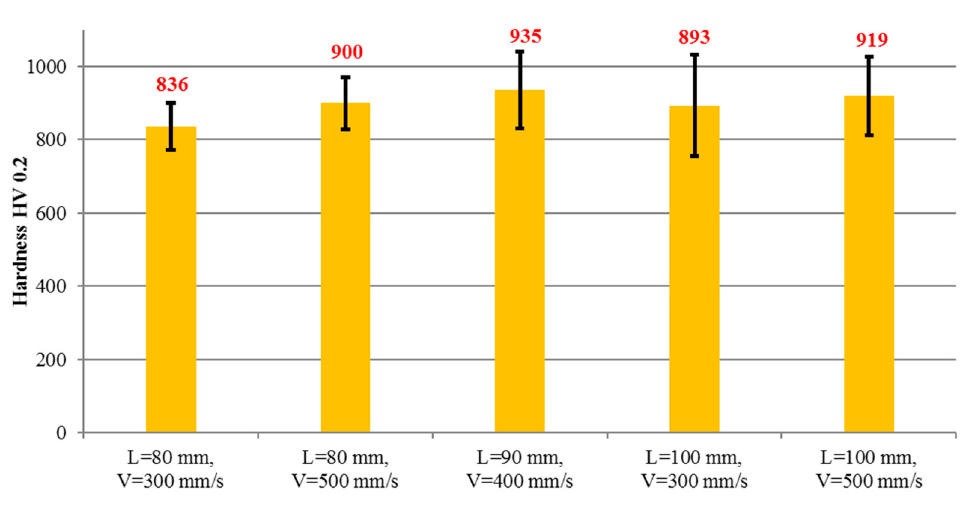
Figure 10. Mean values of coating’s microhardness.